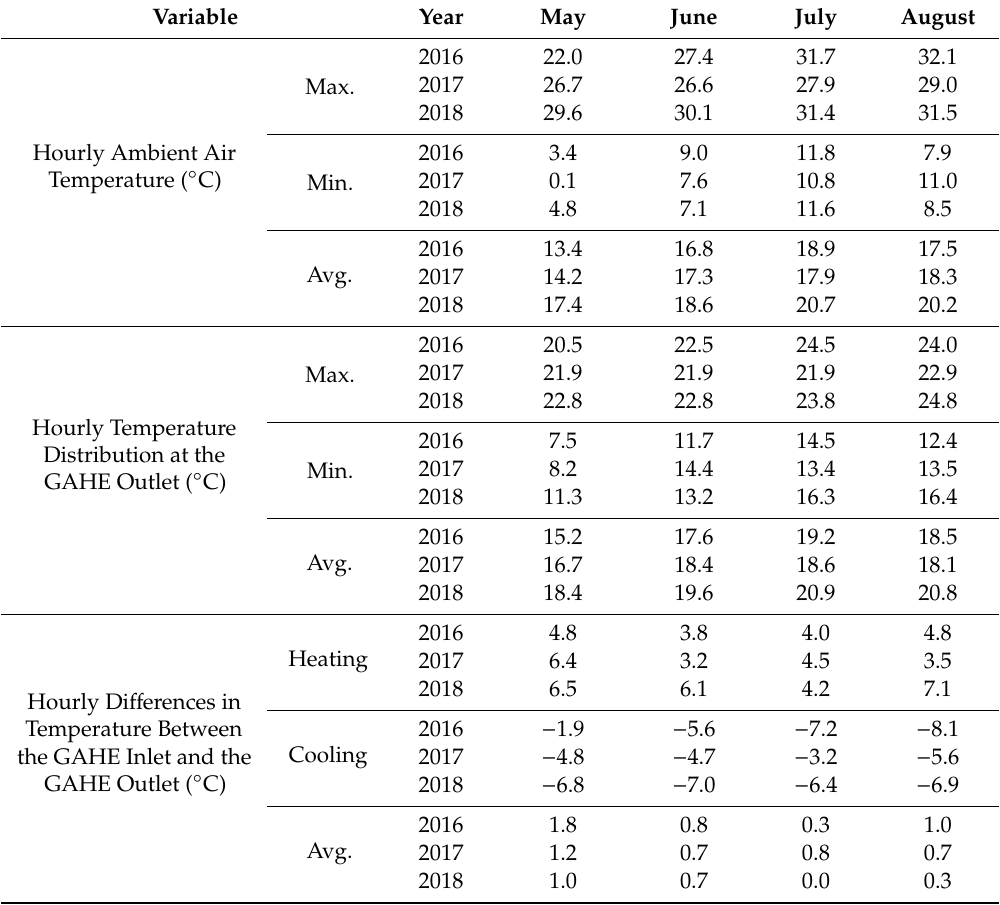
Table 1. Distribution of average hourly temperatures measured at the GAHE inlet and outlet